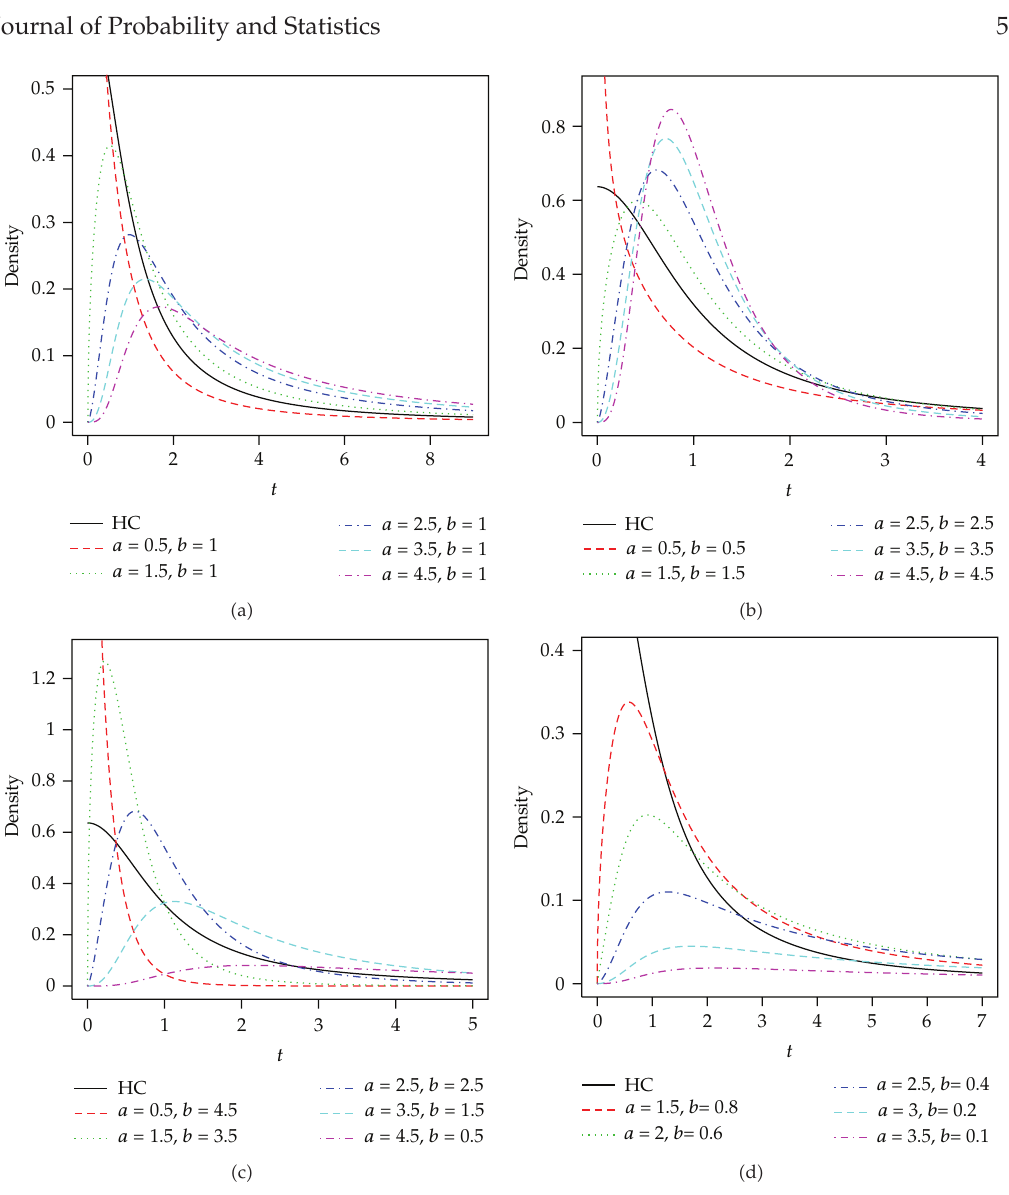
Figure 1: Plots of the density function (cid:2) 2.3 (cid:5) for some parameter values; φ (cid:6)